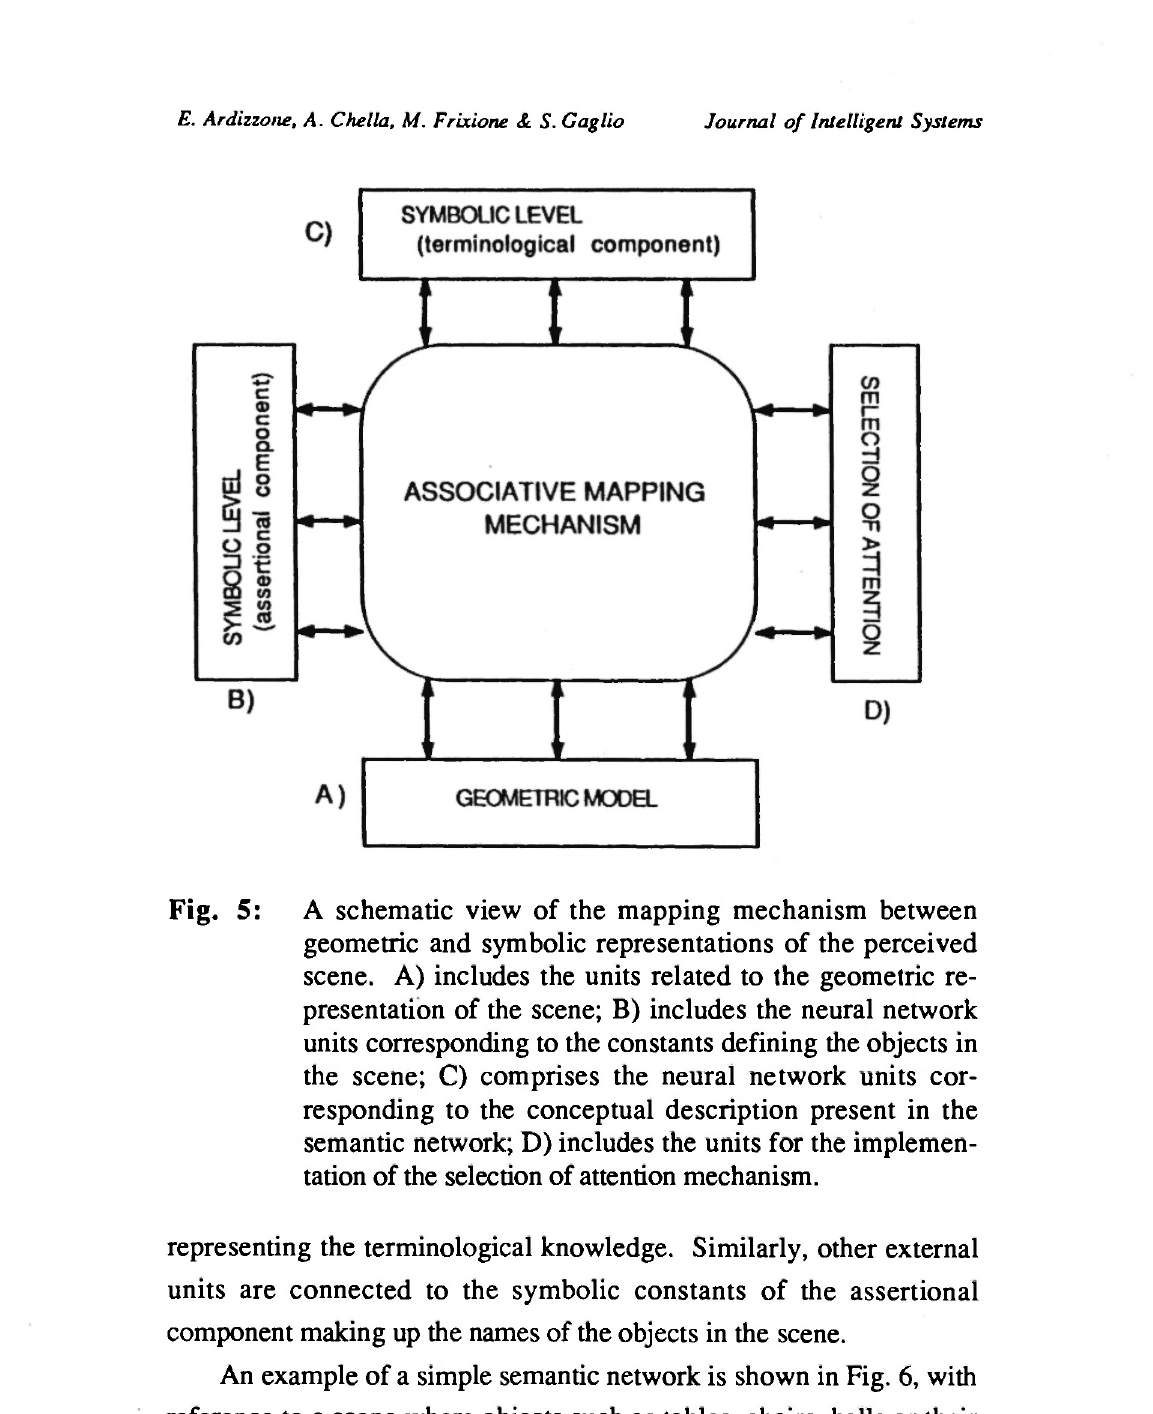
Fig. 5: A schematic view of the mapping mechanism between geometric and symbolic representations of the perceived scene. A) includes the units related to the geometric re- presentation of the scene; B) includes the neural network units corresponding to the constants defining the objects in the scene; C) comprises the neural network units cor- responding to the conceptual description present in the semantic network; D) includes the units for the implemen- tation of the selection of attention